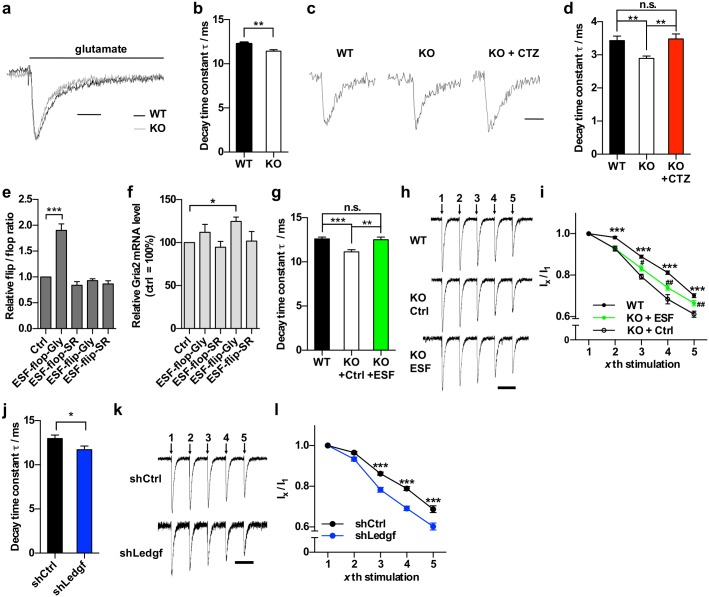
Altered AMPA receptor decay kinetics and synaptic transmission in Mecp2 KO cortical neurons can be reversed by ESF.(a) Representative sample trace of glutamate-evoked current in WT and Mecp2 KO cortical neurons. Scale bar = 15ms. (b) Quantification of decay time constant τ of glutamate-evoked current in WT and Mecp2 KO cortical neurons. Mean ± S.E.M is plotted. n = 37 for WT, n = 33 for KO. ** P < 0.01; two tailed t-test. (c) Representative mEPSC sample trace in WT and Mecp2 KO cortical neurons with or without CTZ treatment. Scale bar = 10ms. (d) Quantification of decay time constant τ of mEPSC. Mean ± S.E.M is plotted. n = 42 for WT, n = 46 for KO, n = 38 for KO + CTZ. ** P < 0.01; one-way ANOVA with Tukey’s multiple comparisons test. (e-f) qRT-PCR analysis the flip/flop ratio (e) and total Gria2 minigene (f) expression in HEK 293 cells co-transfected with indicated ESF and the Gria2 minigene. Mean ± S.E.M is plotted. n = 4 for each group. * P < 0.05, *** P < 0.001; two tailed t-test. (g) Quantification of decay time constant τ of glutamate-evoked current in WT, Mecp2 KO (KO+Ctrl) and Mecp2 KO cortical neurons infected with ESF-flop-Gly lentivirus (KO+ESF). Recording was done on acute slice from mouse infected with lentivirus two weeks after stereotaxic injection. Mean ± S.E.M is plotted. n = 50 for WT, n = 26 for KO+Ctrl, n = 27 for KO+ESF. ** P < 0.01, *** P < 0.001; one-way ANOVA with Tukey’s multiple comparisons test. (h) Representative sample trace of AMPAR-mediated current in response to repetitive stimulations in WT and Mecp2 KO neurons infected with control or ESF-flop-Gly lentivirus (KO+Ctrl or KO+ESF). Scale bar, 100ms. (i) Relative current amplitude of the xth stimulation to first stimulation in WT and Mecp2 KO neurons infected with either control or ESF-flop-Gly lentivirus (KO+Ctrl or KO+ESF). Mean ± S.E.M is plotted. n = 36 for WT, n = 18 for KO+Ctrl, n = 18 for KO+ESF. Asterisk denotes P-value for comparison between WT and KO+Ctrl, *** P < 0.001. Pound sign denotes P-value for comparison between KO+ESF and KO+Ctrl, # P < 0.05, ## P < 0.01; repeated measures two-way ANOVA with Tukey’s multiple comparisons test. (j) Quantification of decay time constant τ of glutamate-evoked current in neurons infected with shCtrl or shLedgf lentivirus. Mean ± S.E.M is plotted. n = 13 for shCtrl, n = 12 for shLedgf, * P < 0.05; two-tailed t-test. (k) Representative sample trace of AMPAR-mediated current in response to repetitive stimulations in neurons infected with shCtrl or shLedgf lentivirus. Scale bar, 100ms. (l) Relative current amplitude of xth stimulation to first stimulation in neurons infected with shCtrl or shLedgf. Mean ± S.E.M is plotted. n = 12 for each group, *** P < 0.001; repeated measures two-way ANOVA with Tukey's multiple comparisons test.